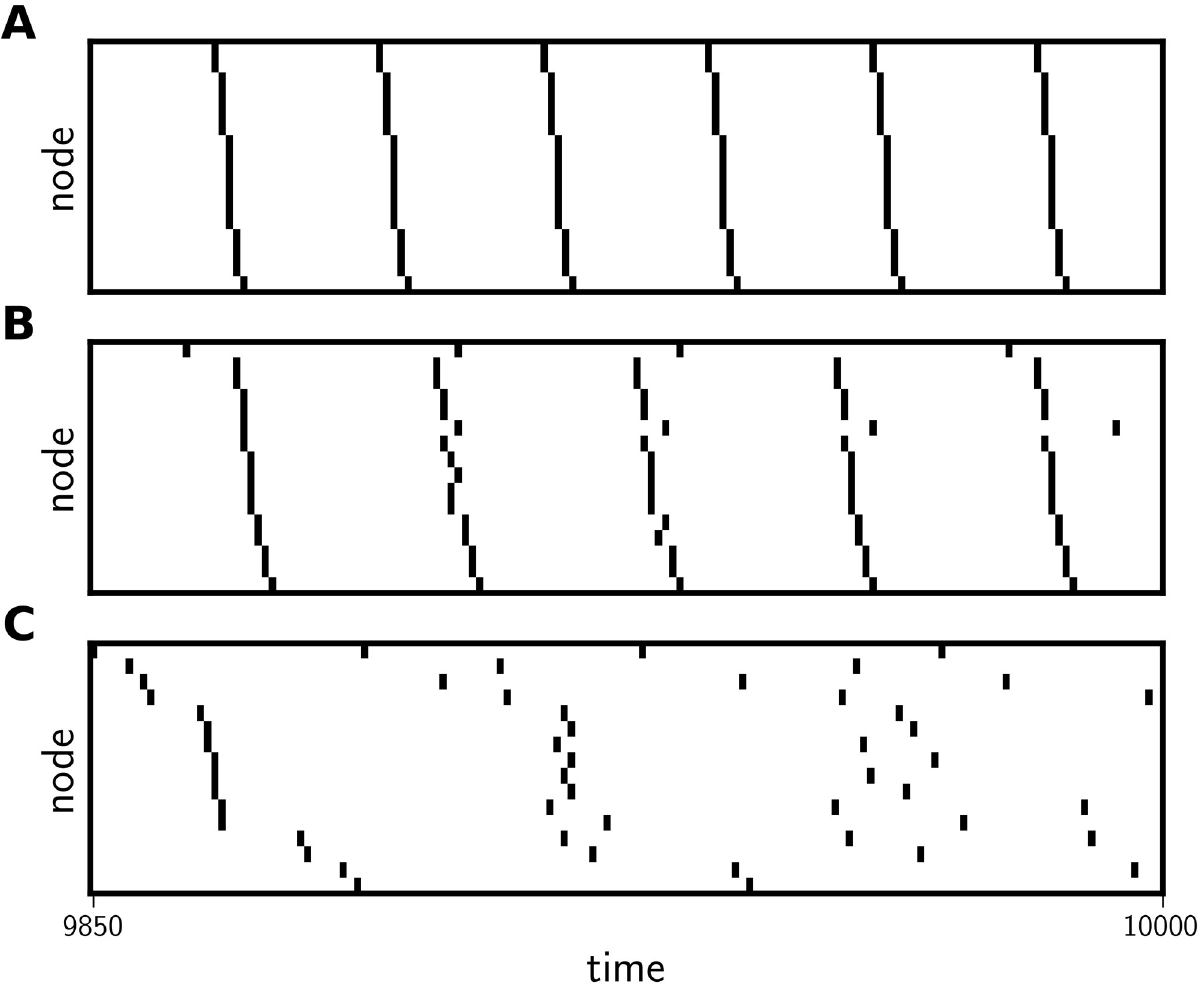
Fig 2. Spike arrays from temporally-regular, chimeric, and temporally-irregular network states. Spike arrays showing the last 150 time-steps of three different network states categorized by ISI statistics as temporally-regular (A), chimeric (B), and temporally-irregular (C). Nodes are sorted by increasing time to the first spike. Compare the perfect timing (all spikes occur with the exact same ISI) in A to the random spiking in C .